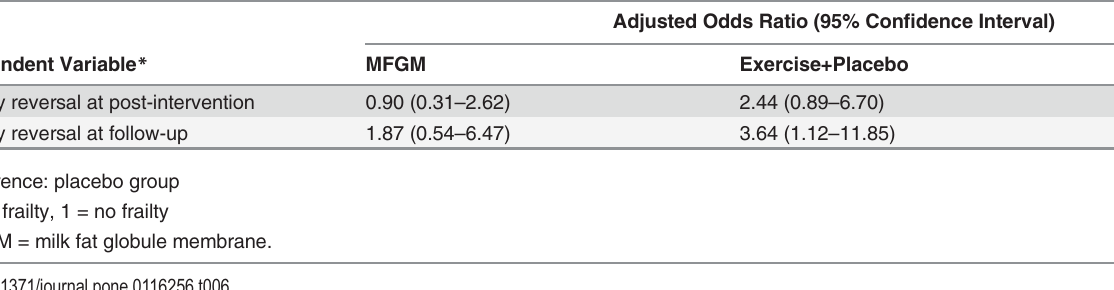
Table 6. Adjusted Odds Ratios with 95% Con fi dence Intervals for frailty at post-intervention and follow-up by intention to treat